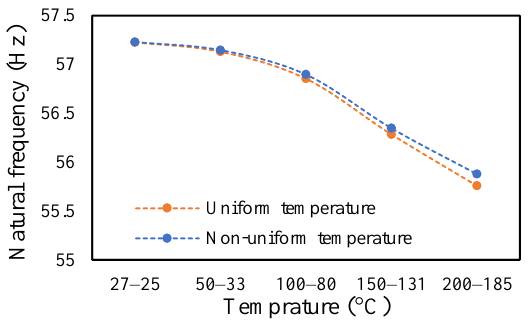
Figure 21. Comparison of natural frequency of 0.5 mm crack depth ramped at 2 °C/min.